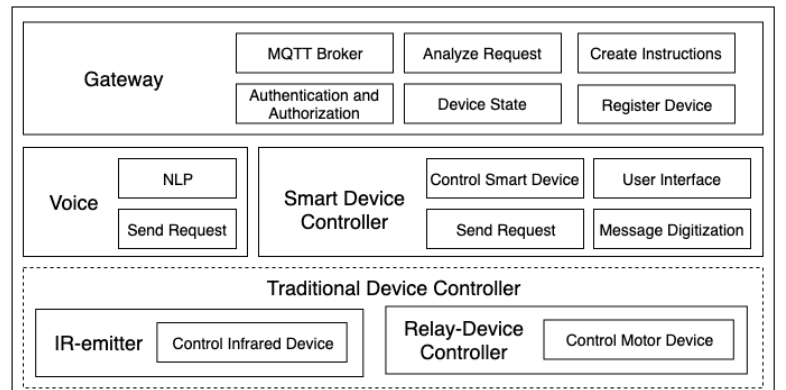
Figure 1. The proposed framework.